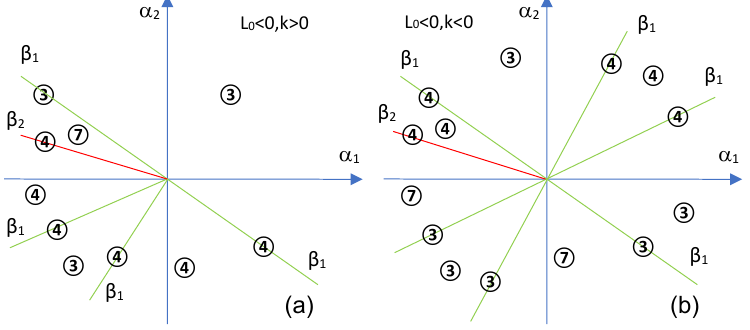
Figure 2. Bifurcation diagrams when p < 0, r < 0, and hk > 0: ( a ) L 0 < 0, k > 0; ( b ) L 0 < 0, k <